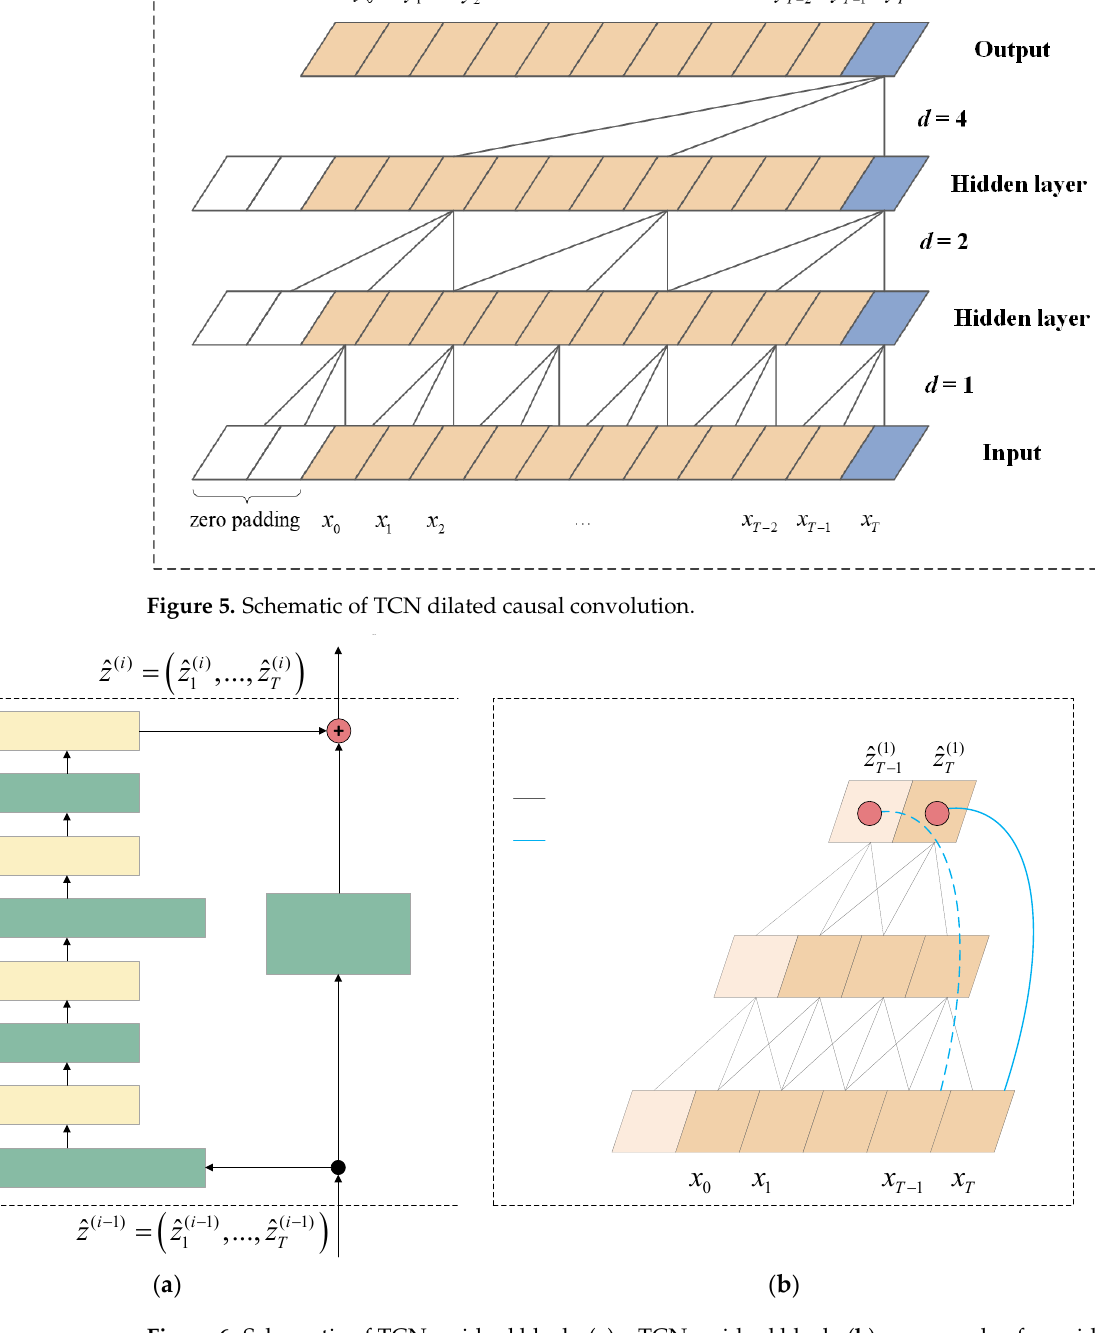
Figure 6. Schematic of TCN residual block. ( a ) a TCN residual block; ( b ) an example of a residual connection in TCN.